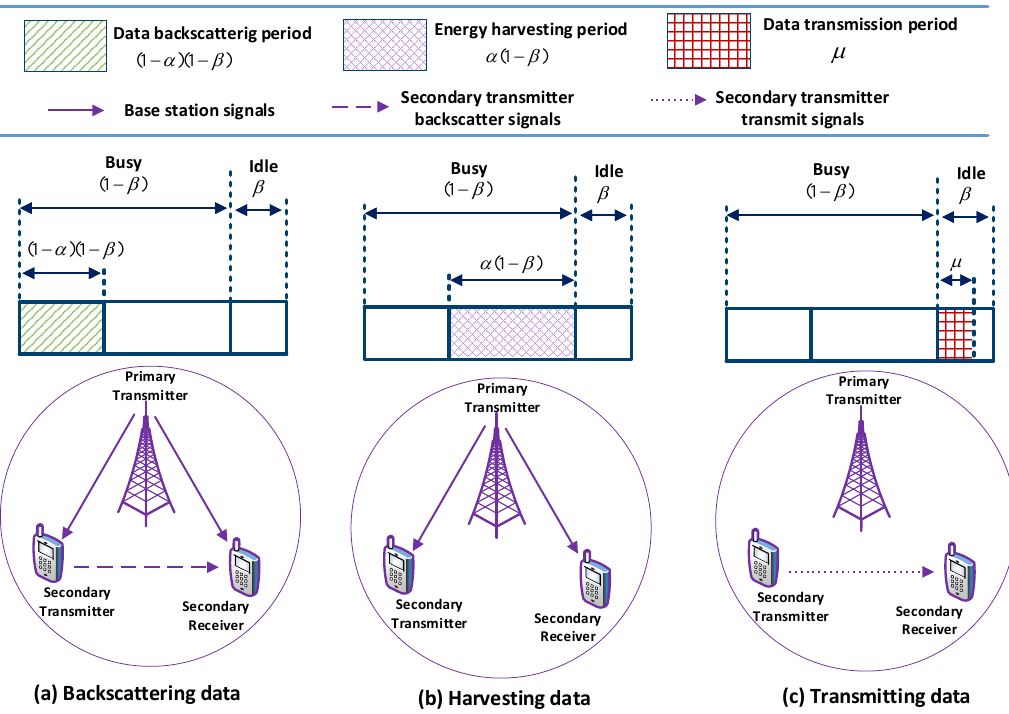
Figure 34. RF-powered cognitive radio network with